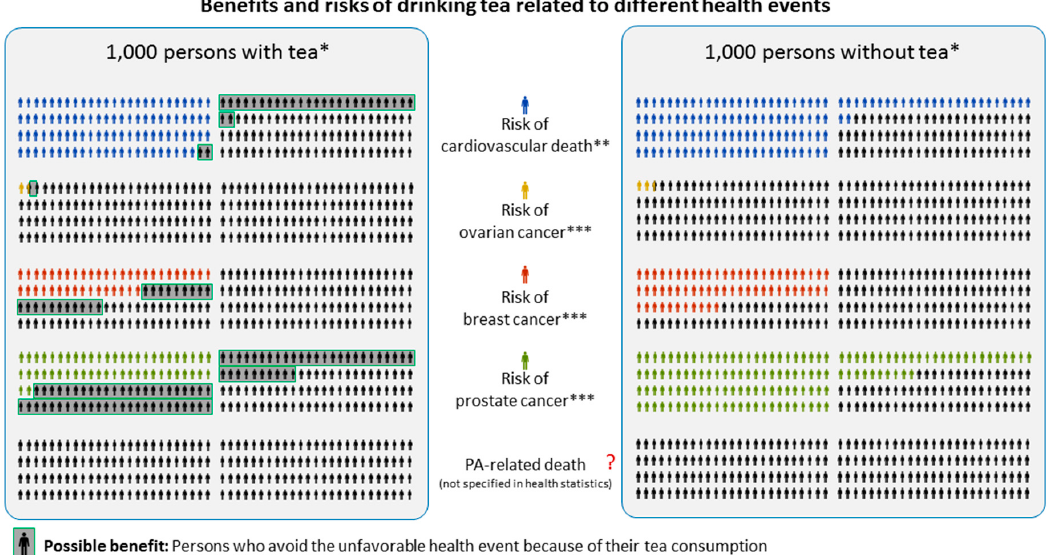
Figure 1. Icon array. Comparison of benefits and risks of drinking tea related to cardiovascular death [119], ovarian cancer [120], breast cancer [121], and prostate cancer [122]. All three cancer studies were case-control studies. Thus, reported data were adjusted to the lifetime risk of developing either ovarian (1:80), breast (1:7) or prostate cancer (1:6). * The precise definition of “with tea” and “without tea” differs in the considered studies, ** Among patients after myocardial infarction, *** Gender specific populations.